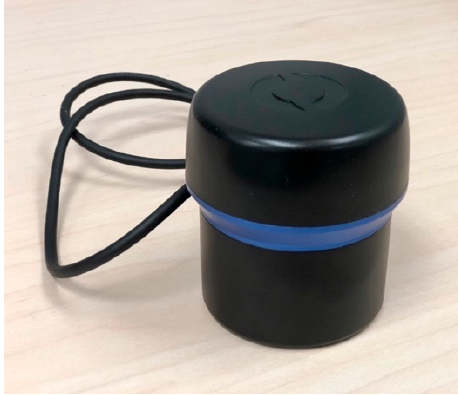
Figure 2. Ping360 mechanical scanning imaging sonar.